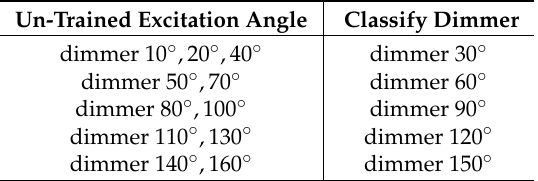
Table 4. Classification of untrained dimmer’s excitation angle to a known output.